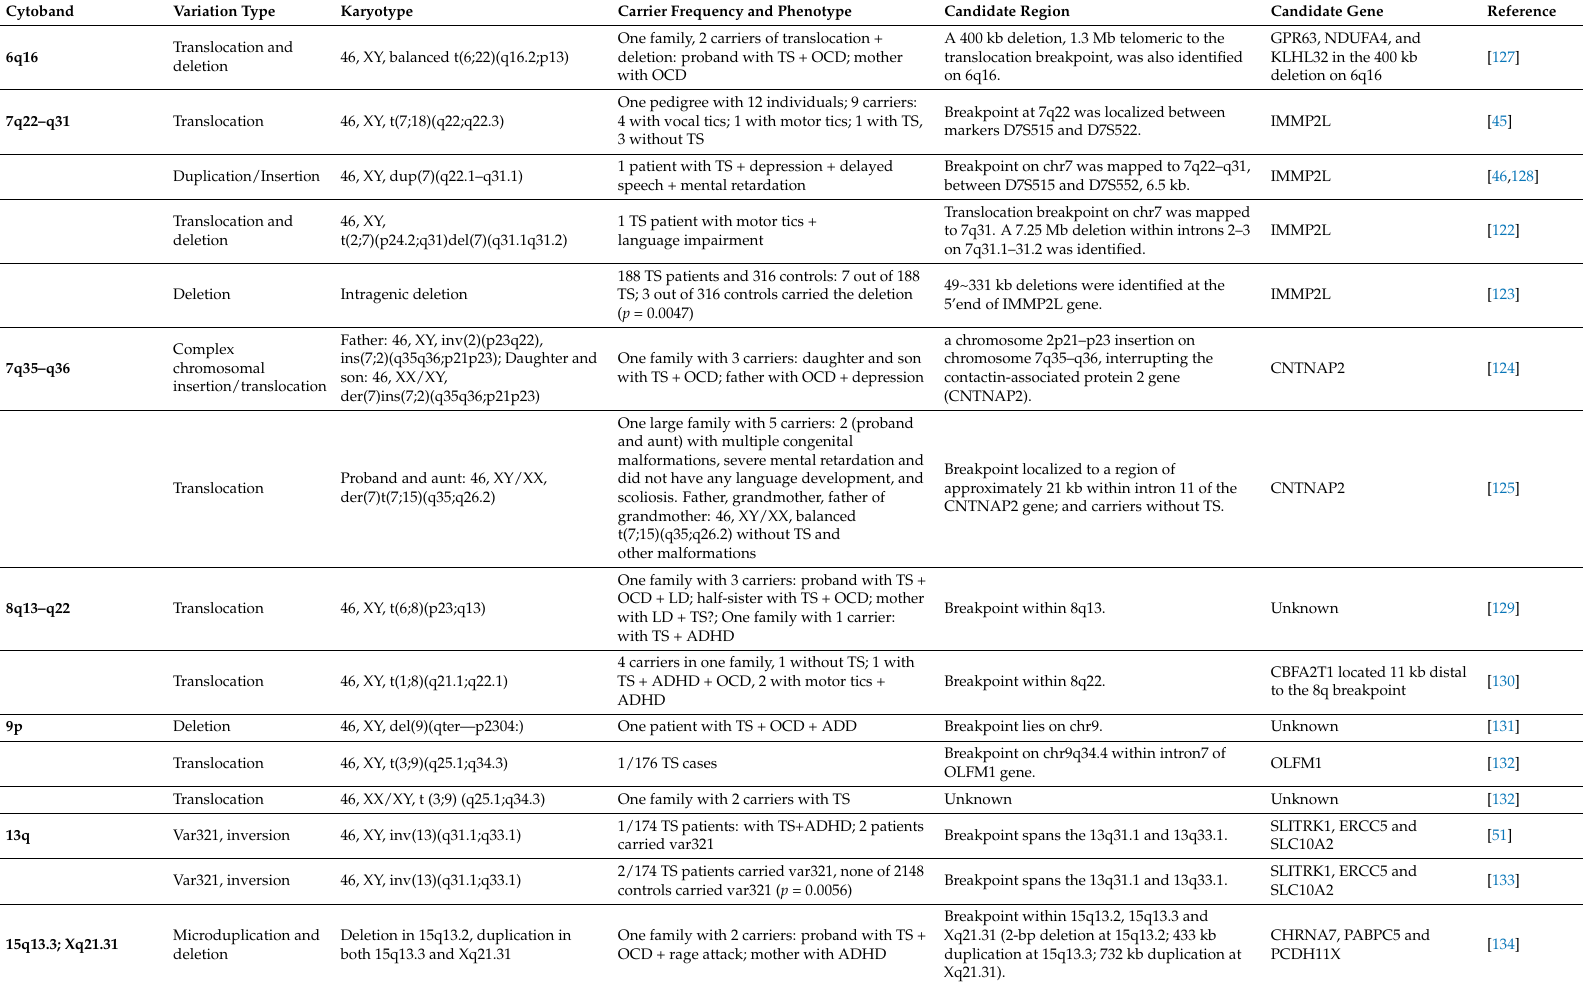
Table 3. Genomic structural aberrations in